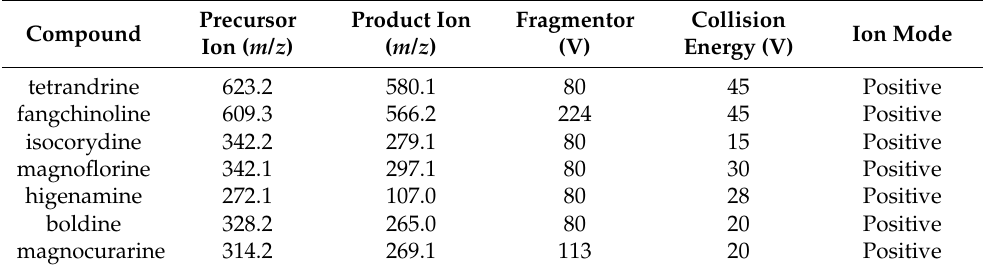
Table 4. Mass spectrometry parameters of seven target